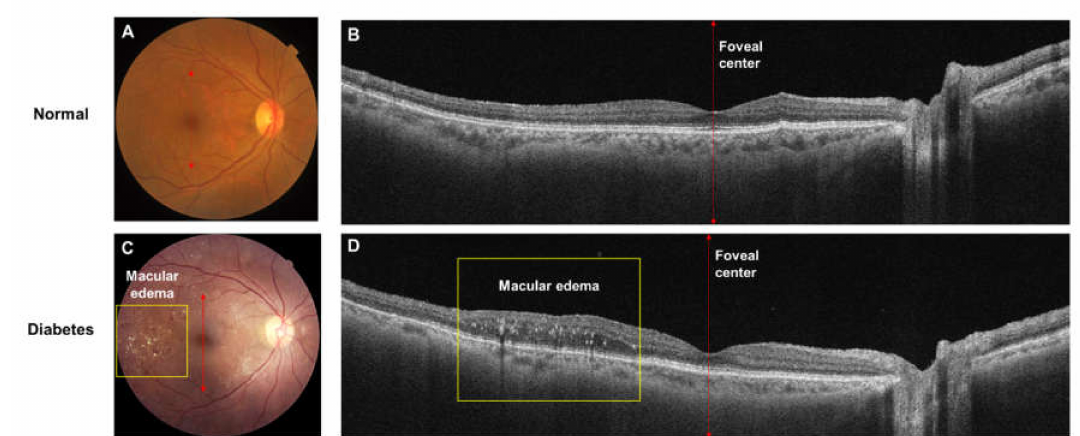
Figure 2. (Top row; A, B) Images of the right eye of a 58-year-old woman, without any chronic systemic diseases or eye diseases. ( A ) Color fundus photograph. ( B ) widefield optical coherence tomography (OCT) of a horizontal scan through the center of the fovea (red line) revealing a normal retina. (Bottom row, C , D ) Images of the right eye of a 45-year-old man with signs of moderate non-proliferative diabetic retinopathy. ( C ) Notably, features include microaneurysms, dot- and blot- hemorrhages and hard exudates (yellow box). ( D ) Wide field OCT of a horizontal scan through the center of the fovea (red line) reveals marked thickening of the retina at the temporal quadrant of the retina (yellow